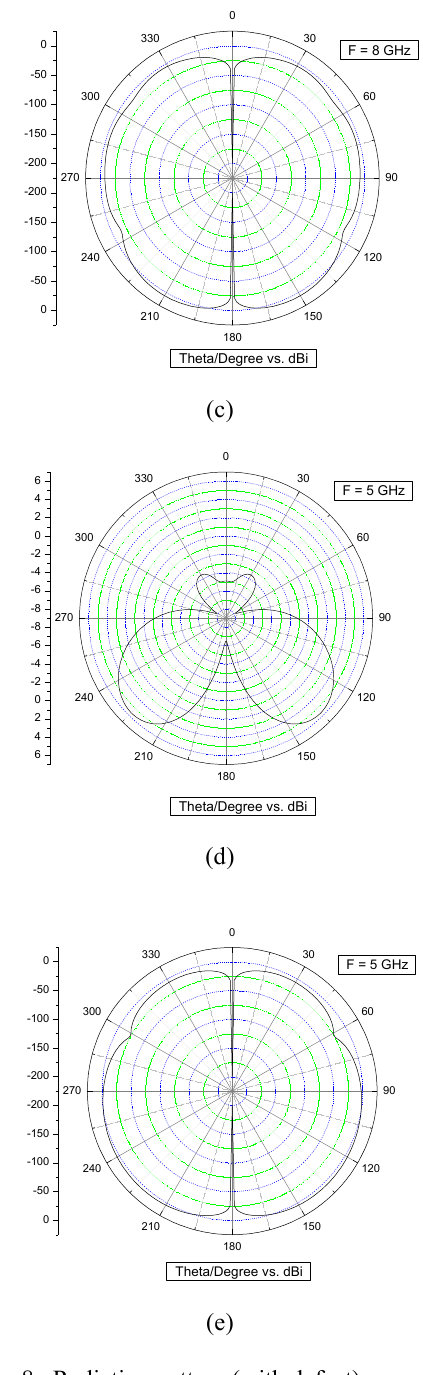
Figure 8. Radiation pattern (with defect) (a) Directivity Abs (Phi = 0) Theta/Degree vs. dBi (8 (b) Directivity Abs (Phi = 90) Theta/Degree vs. dBi (c) Directivity Theta (Phi = 90) Theta/Degree vs.